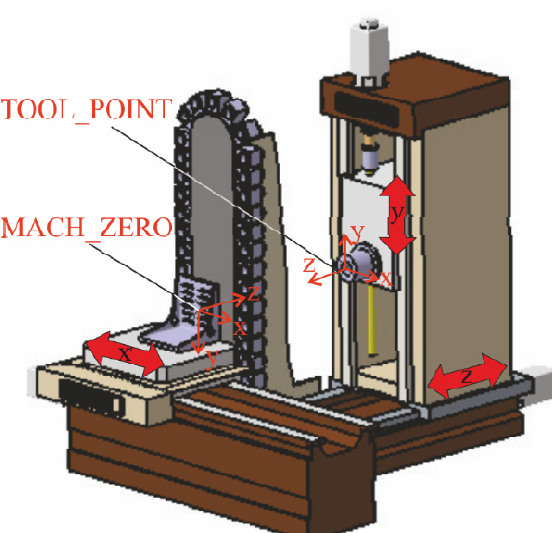
Figure 6. Virtual machine with defined kinematic connec– tions and coordinate systems in CATIA environment